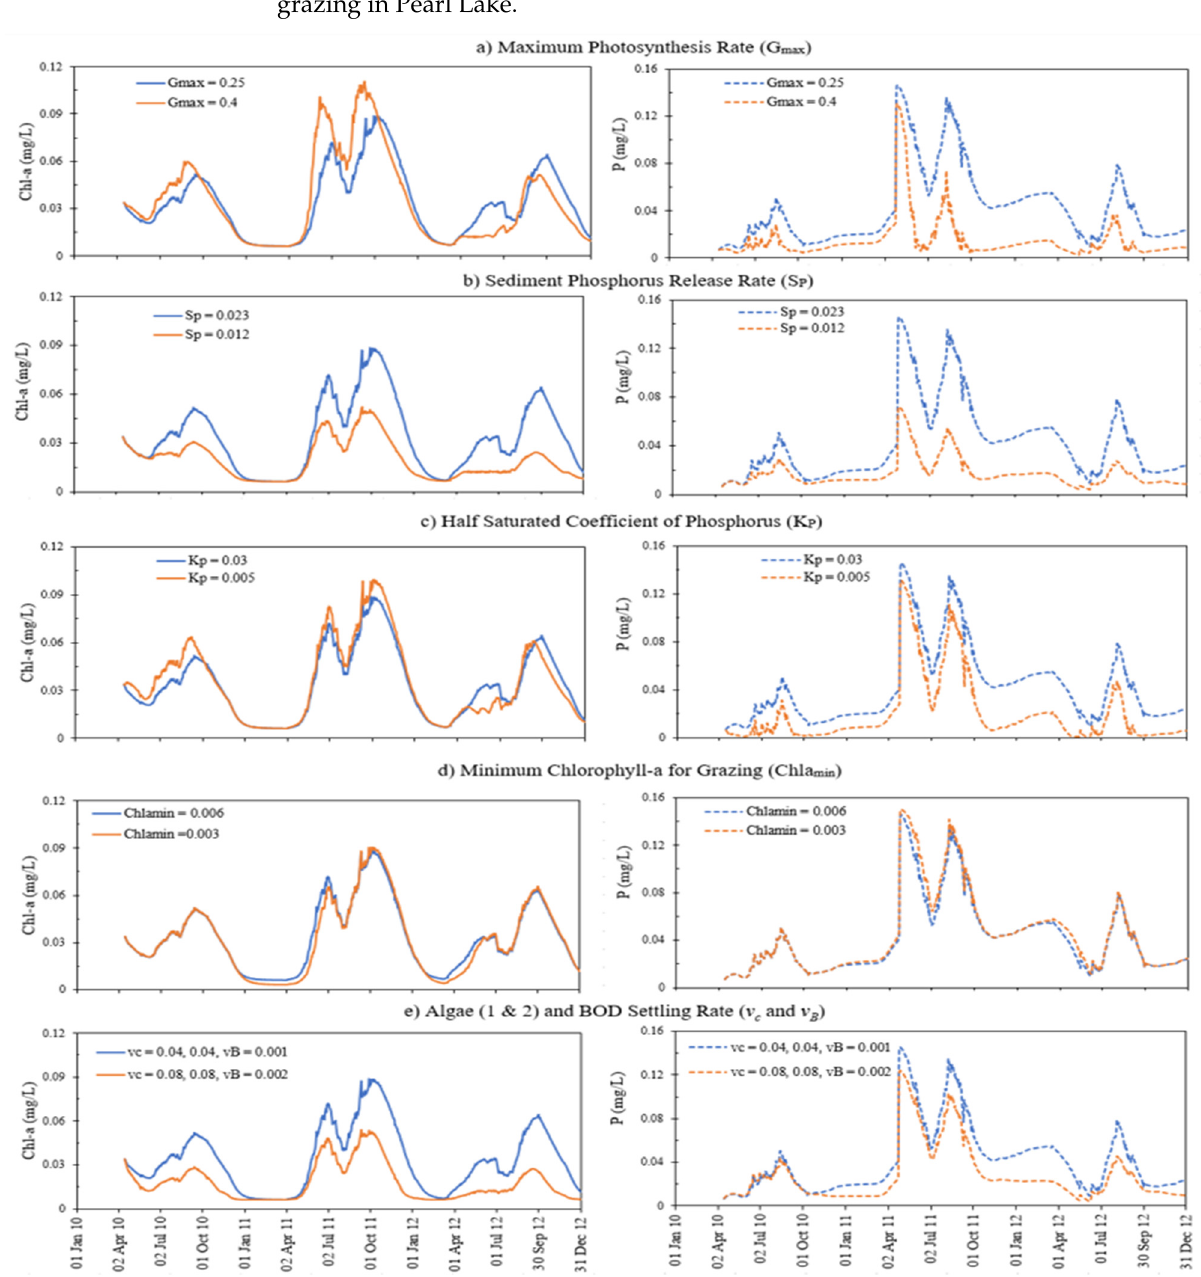
Figure 16. Sensitivity analysis of Chl a ( left panels ) and phosphorus ( right panels ) on ( a ) maximum photosynthesis rate G max , ( b ) sediment phosphorus release rate S P , ( c ) half saturation coefficient of phosphorus K P , ( d ) minimum Chl a for grazing Chla min , and ( e ) algae and BOD settling rates v c , and v B for simulation of Pearl Lake in 2010–2012.